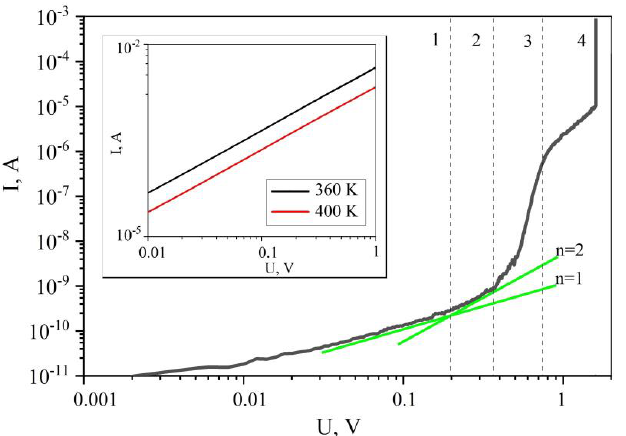
Figure 4. Current–voltage characteristic of the ITO/co-PAEK/Cu structure in logarithmic coordinates, measured at a temperature of 300 K. The thickness of the polymer film is 50 nm. The vertical dashed lines mark the regions (1,2,3,4) on the I - V curve, which characterize different stages of the injection process. The inset shows two I - V curves of the sample in a highly conductive state, measured at temperatures of 360 K and 400 K, respectively.